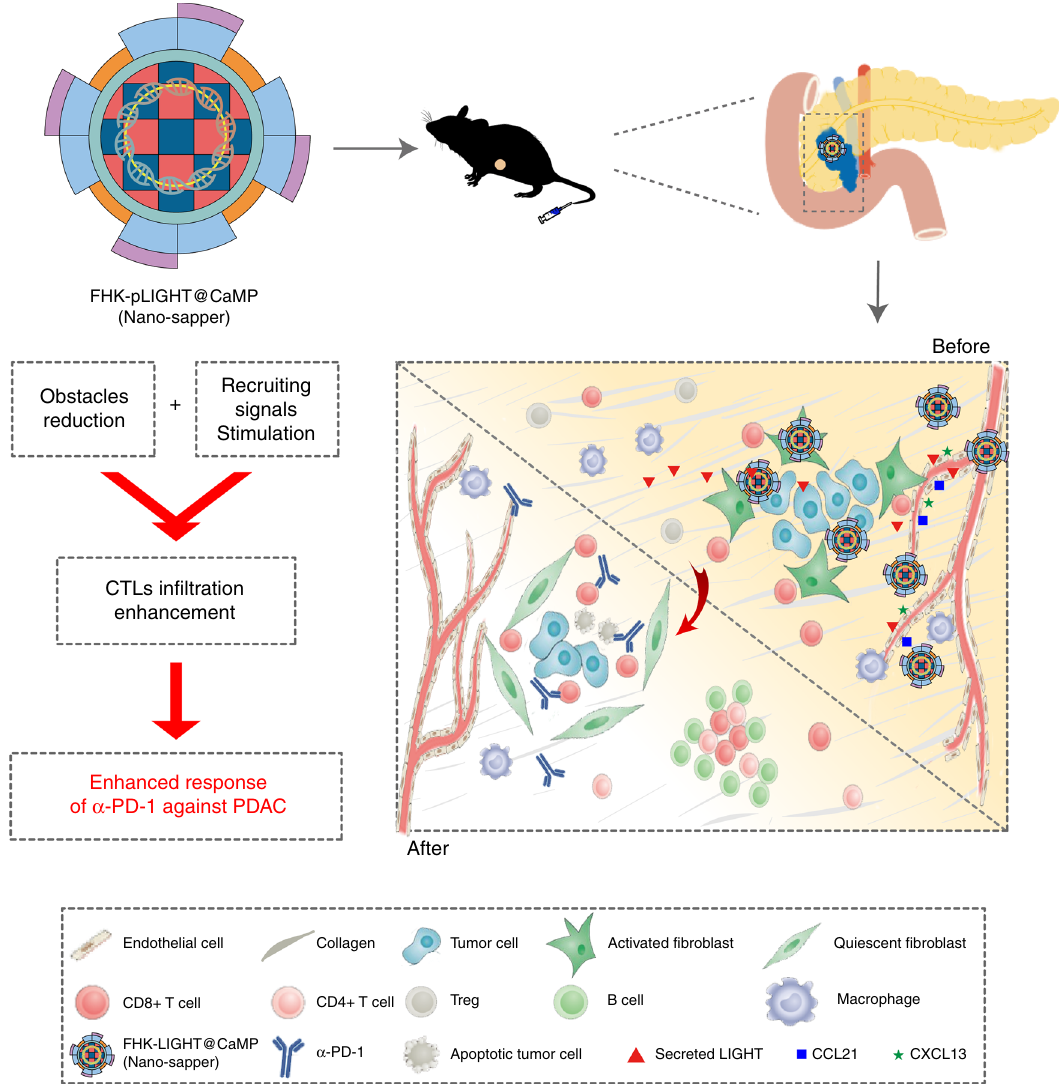
Fig. 1 The expected effects of Nano-sapper synergized with immune-checkpoint inhibitor. Nano-sapper speci fi cally modulate the TME of PDAC, which involves the reduced physical barrier (attenuated stroma and normalized vessels) and the release of chemoattractants recruiting lymphocytes (CCL21 and CXCL13). Once the TME have been reprogrammed by Nano-sapper, a variety of adaptive immune cells migrate to the PDAC and enhance the anti-tumor effects of α